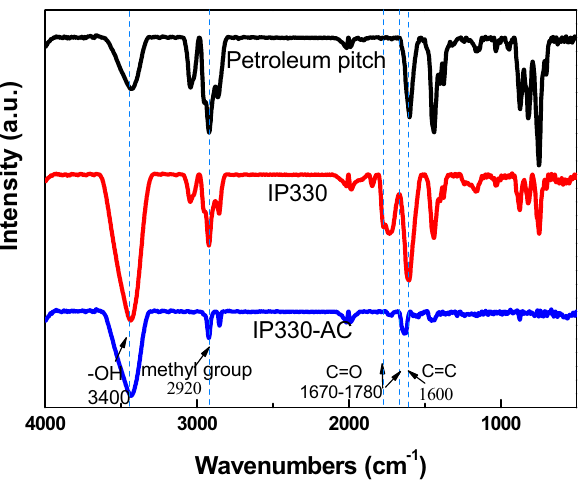
Figure 4. FT-IR spectra of petroleum pitch, surface oxidized pitch, and activated